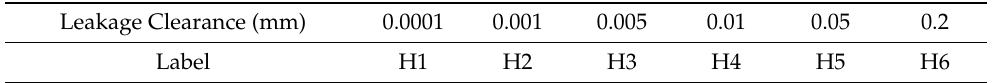
Table 4. Leakage clearance of reversing valve.